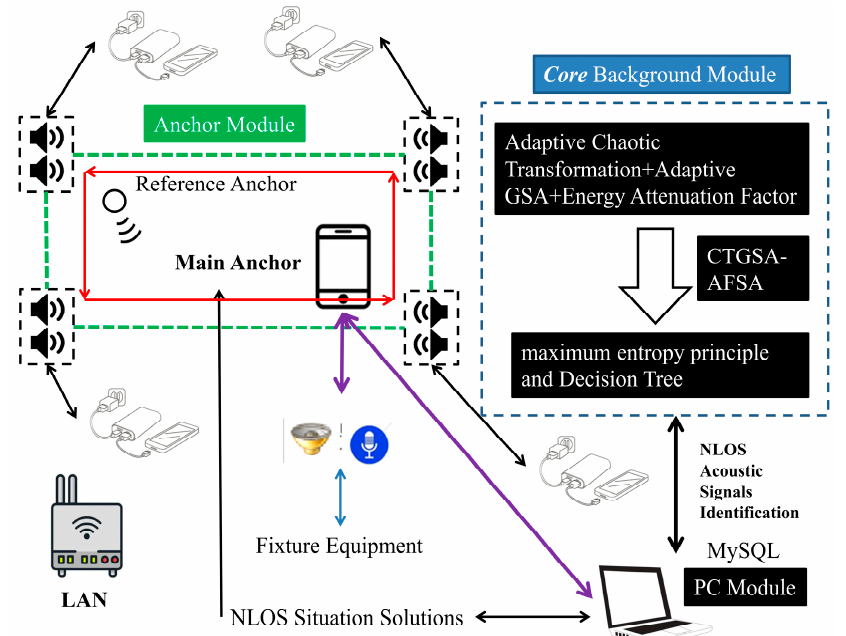
Figure 6. System architecture diagram and man-made routes for flexible NLOS situations.